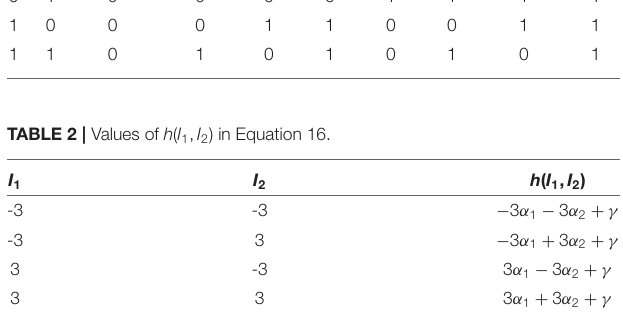
FIGURE 4 | Map of regions for parameters α 2 and γ of DLG.